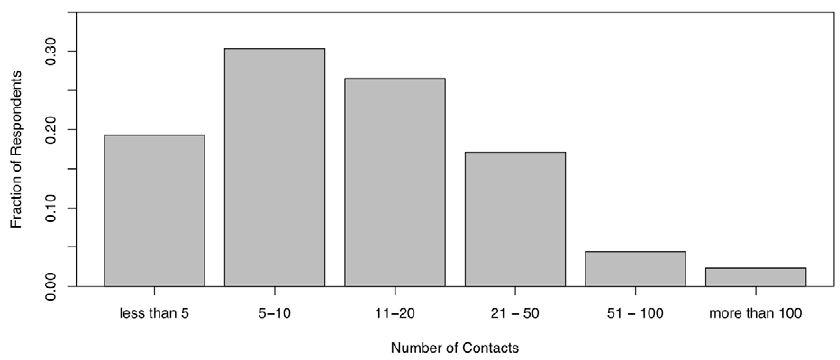
Figure 1. Frequencies of the categories of respondents’ contacts outside the home.